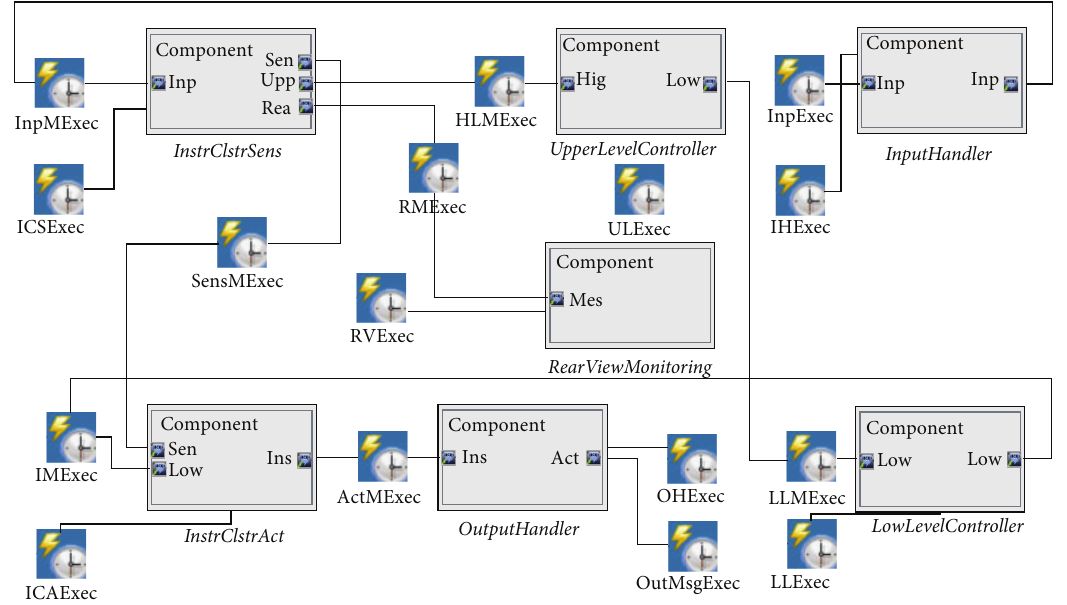
Figure 11: Timing/execution model of ACC